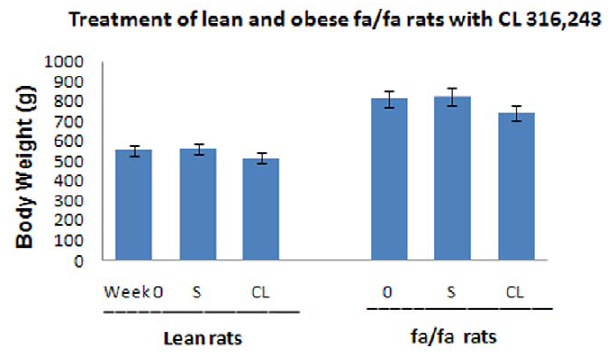
Figure 1. Body weight of both Lean and fa/fa rats. Body weight was measured at week 0 and after 4 weeks treatment with either saline (S) or CL316,243 (CL). *S ignificant effect of CL compared with pretreated state at week 0.